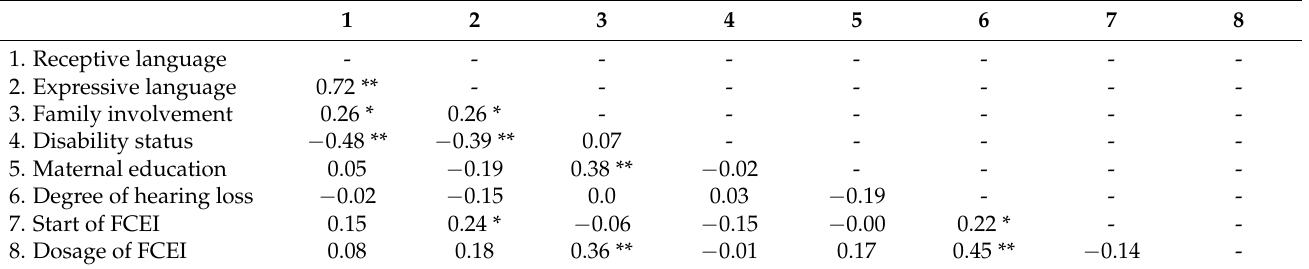
Table 4. Correlations between language outcomes and characteristics of the children with